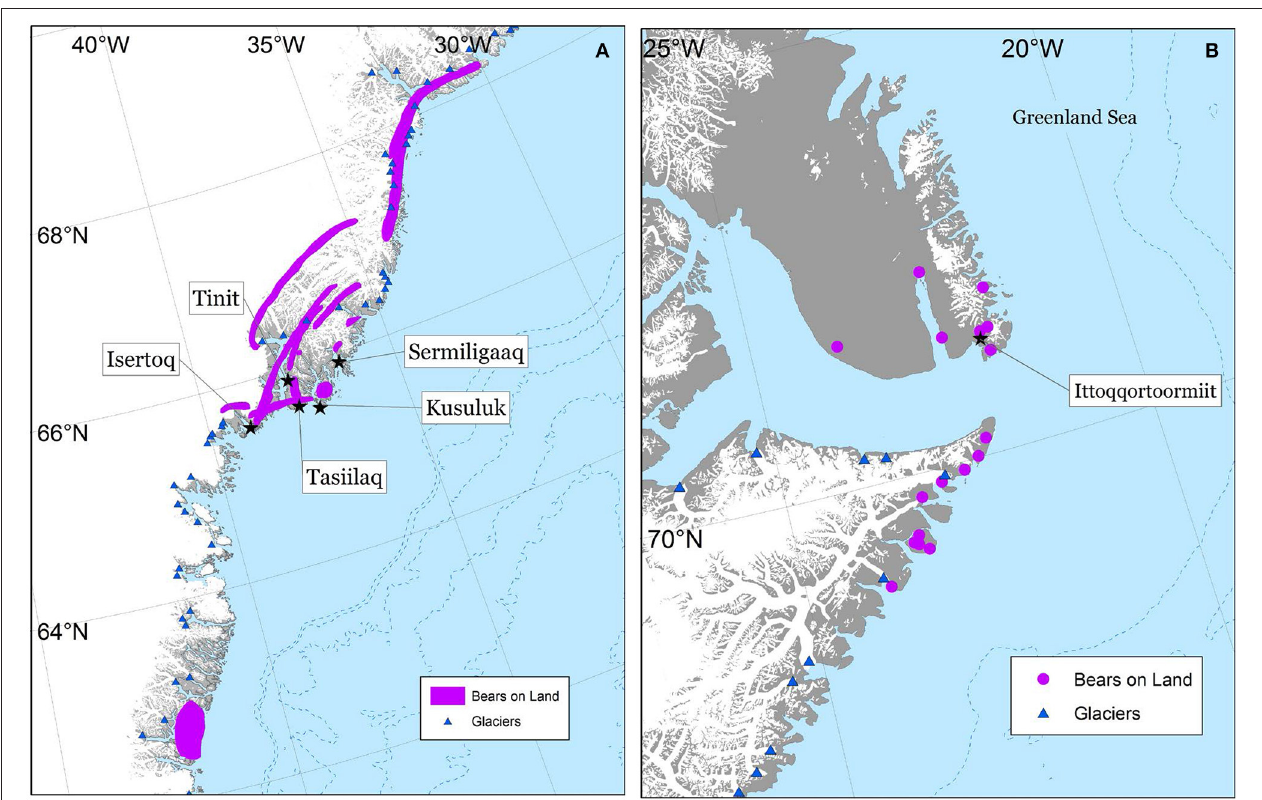
FIGURE 6 | (A,B) Maps of consolidated responses from Tasiilaq hunters ( n = 12) (A) and Ittoqqortoormiit hunters ( n = 7) (B) showing where they have observed bears on glaciers, on land, and in the mountains.